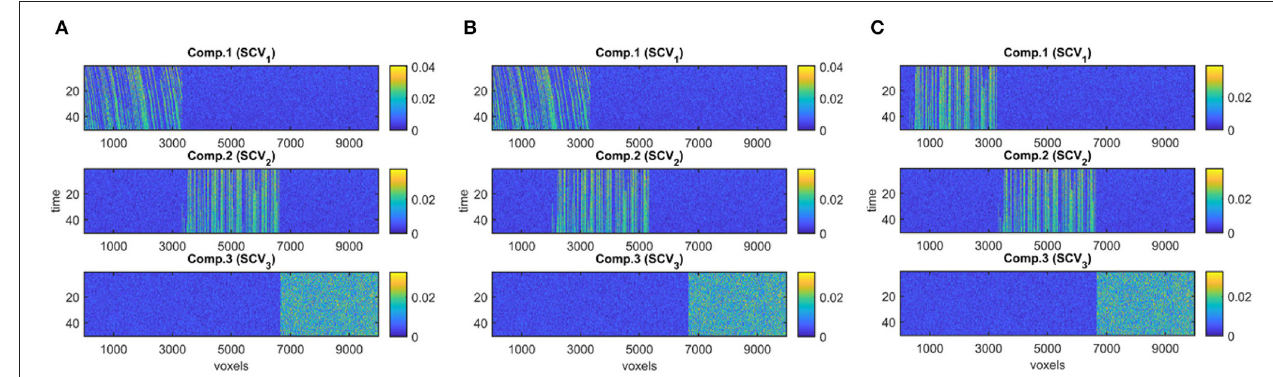
FIGURE 3 | True evolving components ( R = 3), where each component corresponds to a column of B k , for k = 1,...,50, used to generate simulated data with (A) evolving networks, (B) overlapping networks, (C) similar networks.